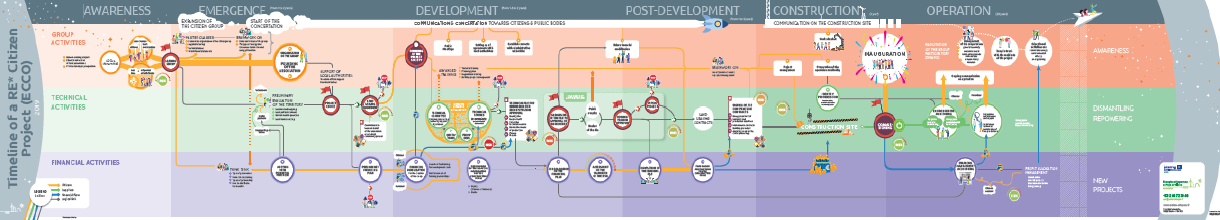
Figure 2. Community energy project